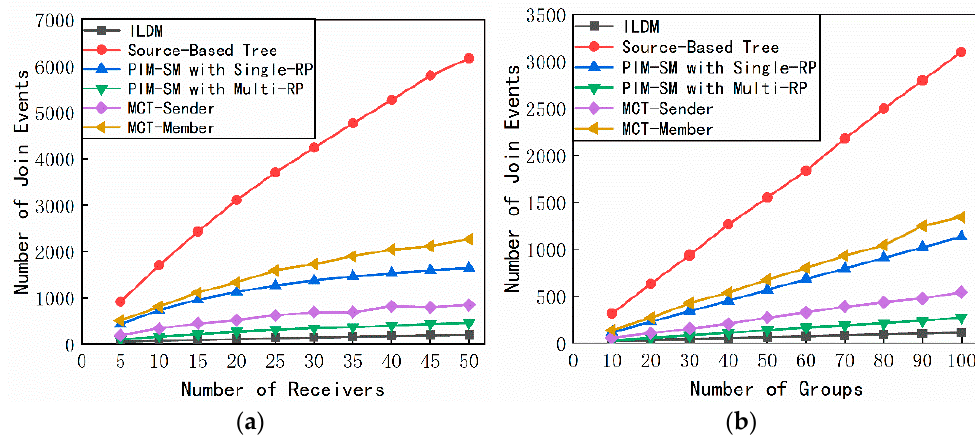
Figure 7. The comparison of the maximum number of join requests. ( a ) The variation trends of the maximum number of join requests with a different number of receivers; ( b ) The variation trends of the maximum number of join requests with a different number of groups.